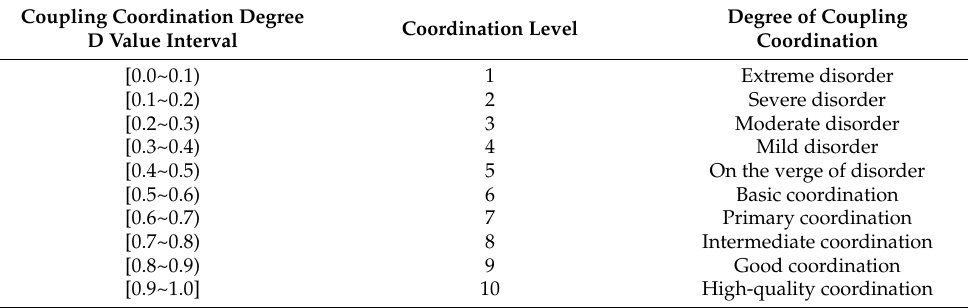
Table 6. Criteria for Dividing the Level of Coupling